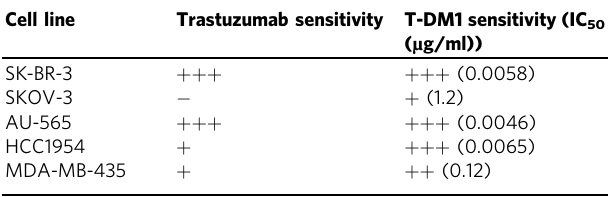
The table shows trastuzumab sensitivity (not sensitive ( − ), low sensitivity ( + ), high sensitivity ( +++ )), and T-DM1 sensitivity (IC 50 average of three experiments) in the indicated cell lines. Graphic presentations of the viability data are found in Fig. 1. Source data